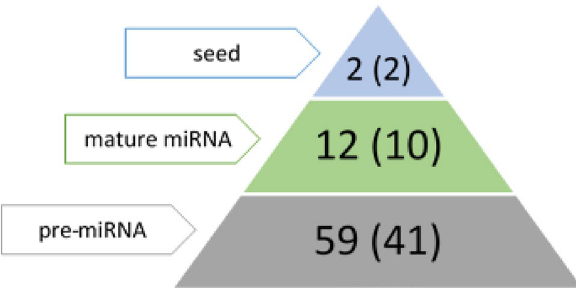
Figure 2. Data on the number of SNPs identified in the seed sequence (blue triangle), in the mature miRNA sequence beyond the seed (green traingle), and in the pre-miRNA sequence beyond the mature miRNA (grey triangle). Numbers in brackets denote the number of miRNAs with such